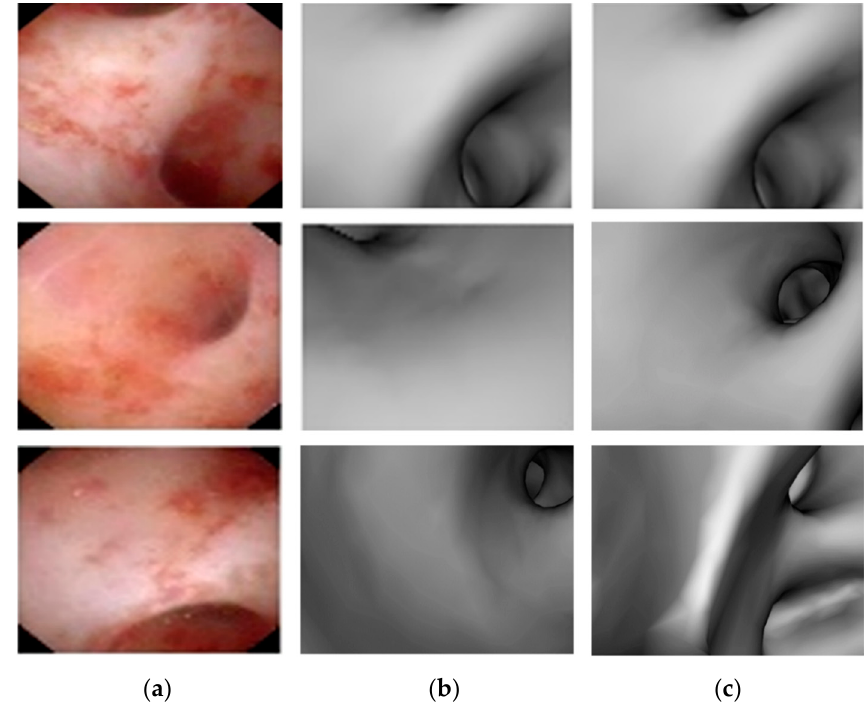
11 of 14 Figure 9. Examples of depth prediction of ureteroscopic video images by style transfer. ( a ) shows